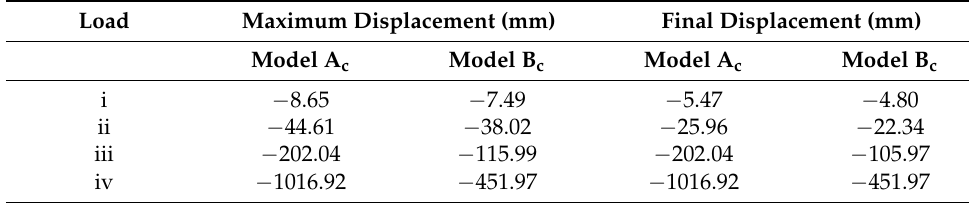
Table 2. Displacements of the interior column bottoms in models A c and B c .